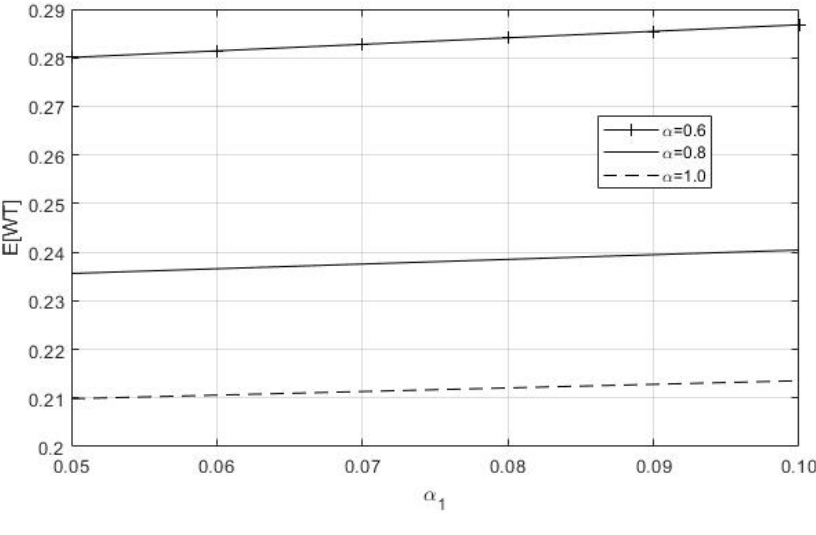
Figure 4: Impact of E [ W T ] on α vs α